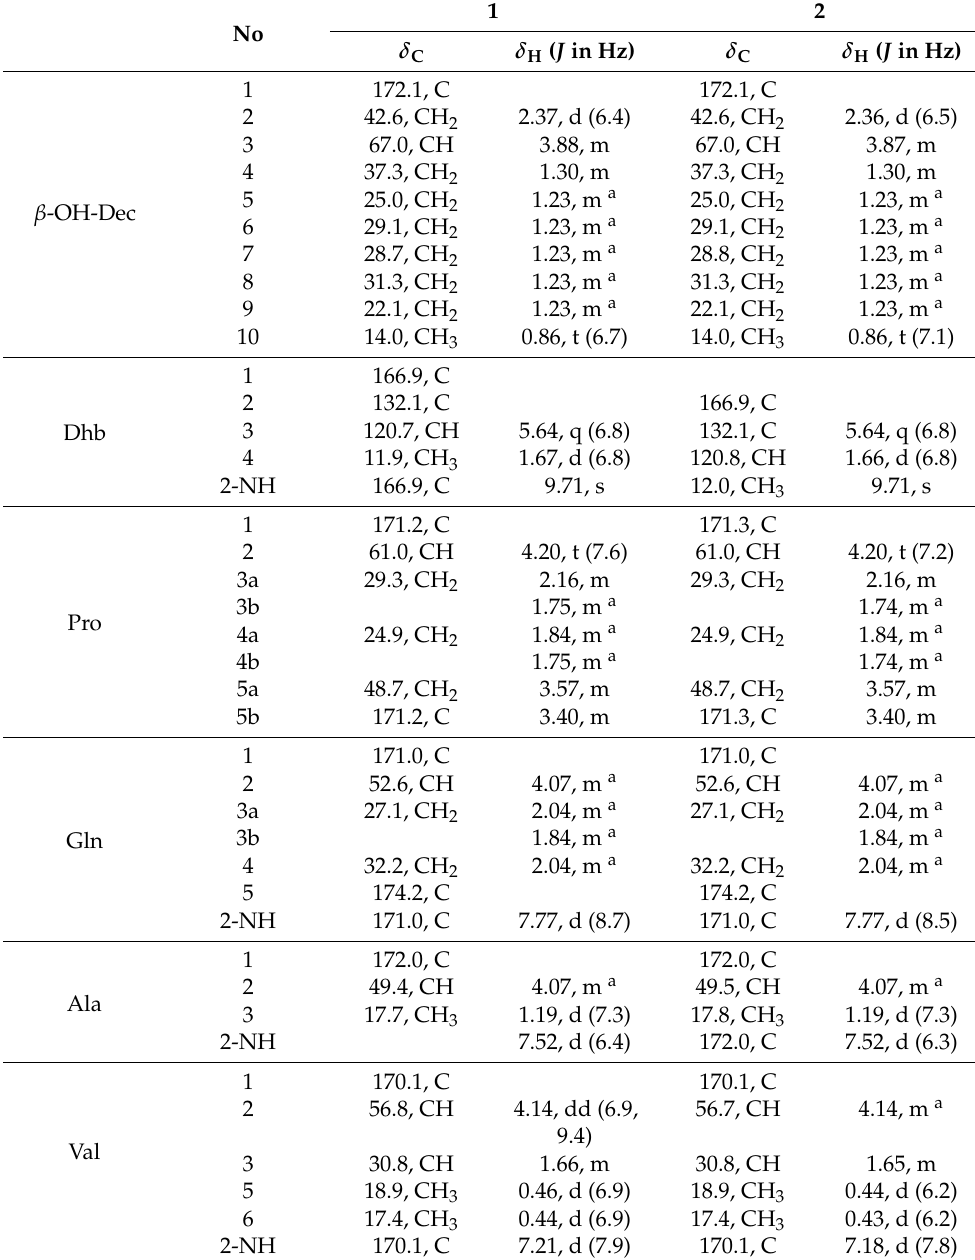
2/H-3/H-4/H-5 or H-6 clearly indicated a Leu in 3 and an Ile in 4 instead of the Val in 2 , respectively. Finally, the complete structures of 3 and 4 were elucidated unambiguously by 2D-NMR correlations (Figure 4) and also fulfilled with tandem MS/MS analysis and feeding experiment (Figure S5). The absolute configurations of Leu in 3 and Ile in 4 were both determined to be D configuration by Marfey’s analysis (Table S3). Table 1. The 1 H (500 MHz) and 13 C NMR (125 MHz) data of 1 – 2 in DMSO- d